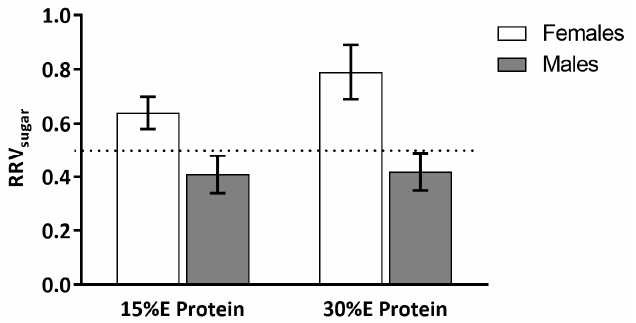
Figure 3. Relative reinforcing value (RRV sugar ) of sweet to savory snack food. There were significant main effects of gender (greater in women) and dietary protein (greater after 30% E protein meal) on RRV sugar . Values are expressed as means ± SE.